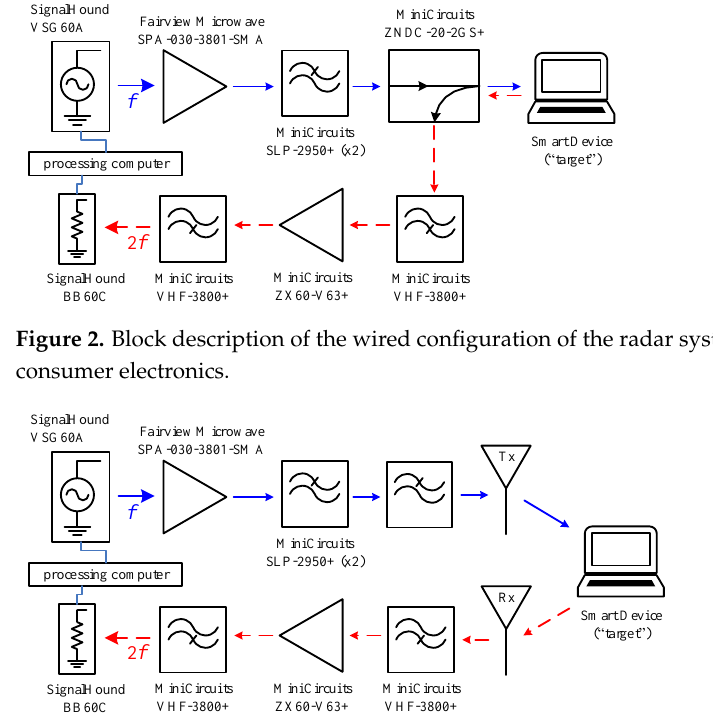
Figure 3. Block description of the wireless configuration of the radar system designed to detect home consumer